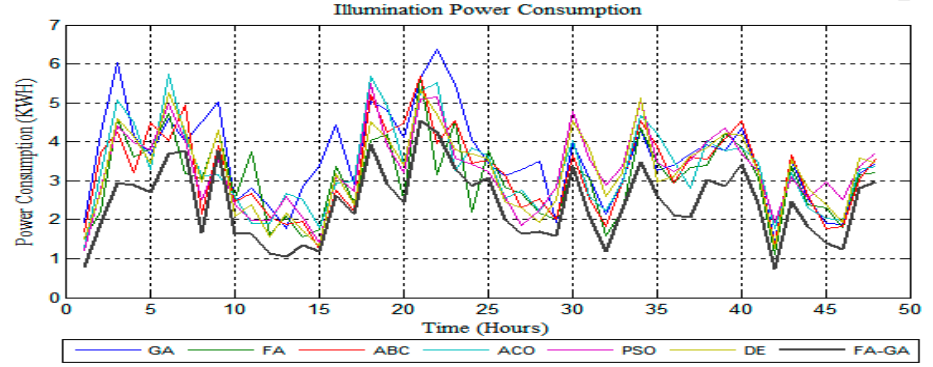
Figure 7. Power consumption for illumination based on the considered approaches.